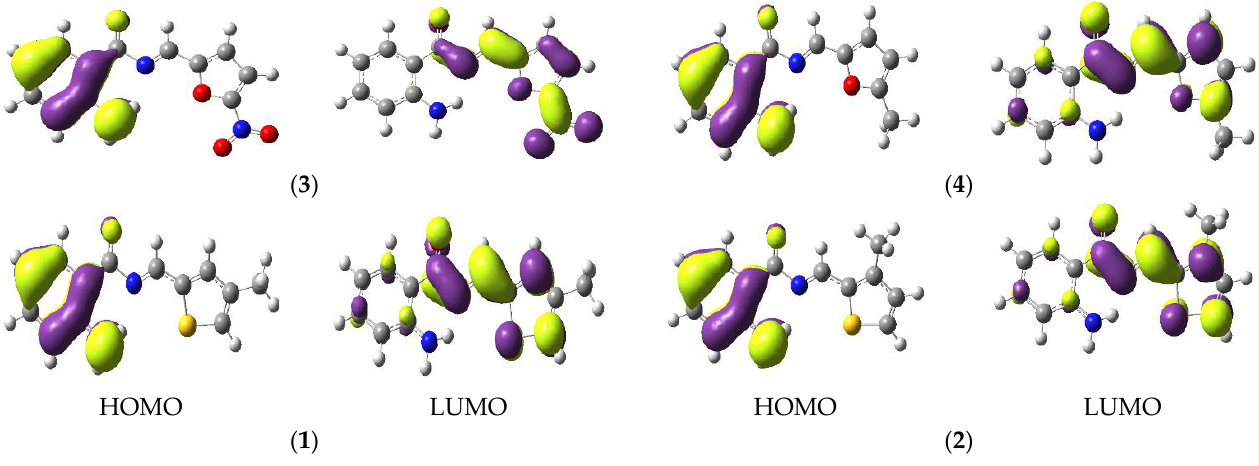
Figure 2. The ground state contours of FMOs (HOMOs and LUMOs) of Schiff derivatives (contour value = 0.035).